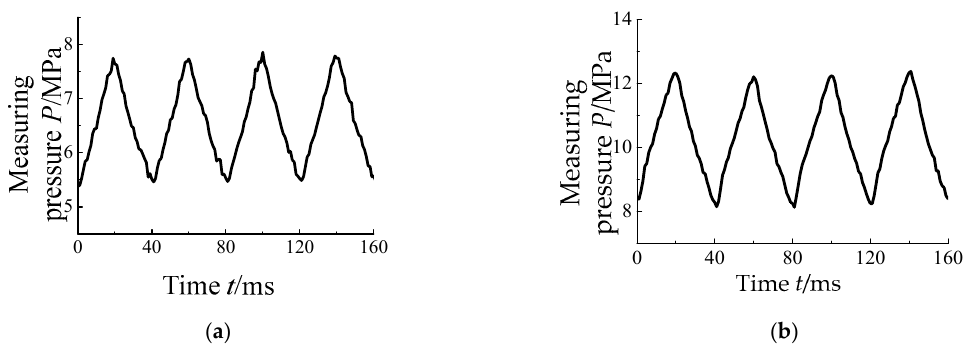
Figure 14. This figure is the experimental result: ( a ) Change of oil film pressure under 20 MPa load; ( b ) change of oil film pressure under 70 MPa load.